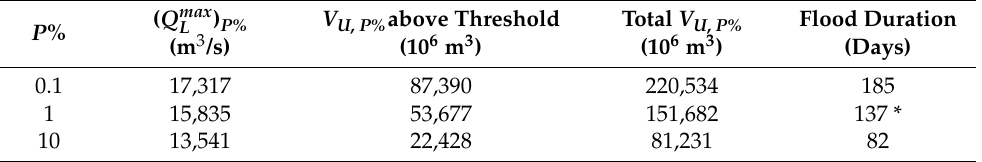
Table 6. Main parameters of MVF Class 2 at Turnu-M ă gurele.